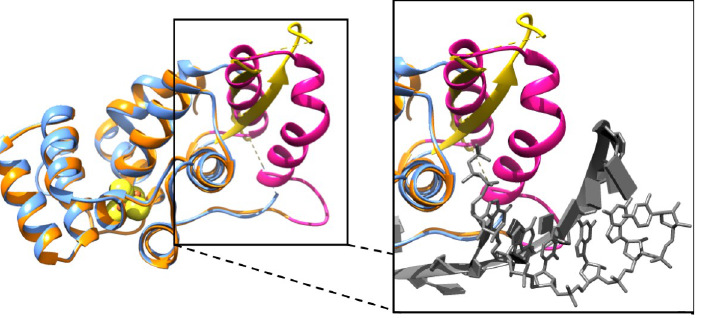
Fig 1. Comparison of the structures of p58C 272-464 and p58C 266-456 . (A) Best-fit superposition over all backbone atoms of the crystal structures of the p58C 272-464 (PDB ID: 3L9Q) and p58C 266-456 (PDB ID: 5F0S) constructs. The substrate in the p58C 266-456 structure is removed for clarity. Inset: Best-fit superposition over all backbone atoms of the DNA binding region with the primed substrate shown in the p58C 266-456 structure. p58C 266-456 is colored orange, p58C 272-464 blue, and the RNA-primed DNA substrate in grey (RNA in sticks, DNA in slabs). In both panels, Leu318-His351 are colored yellow in the p58C 272-464 structure and pink in the p58C 266-456 structure. Connectivity between residues where electron density is missing is indicated by dashed